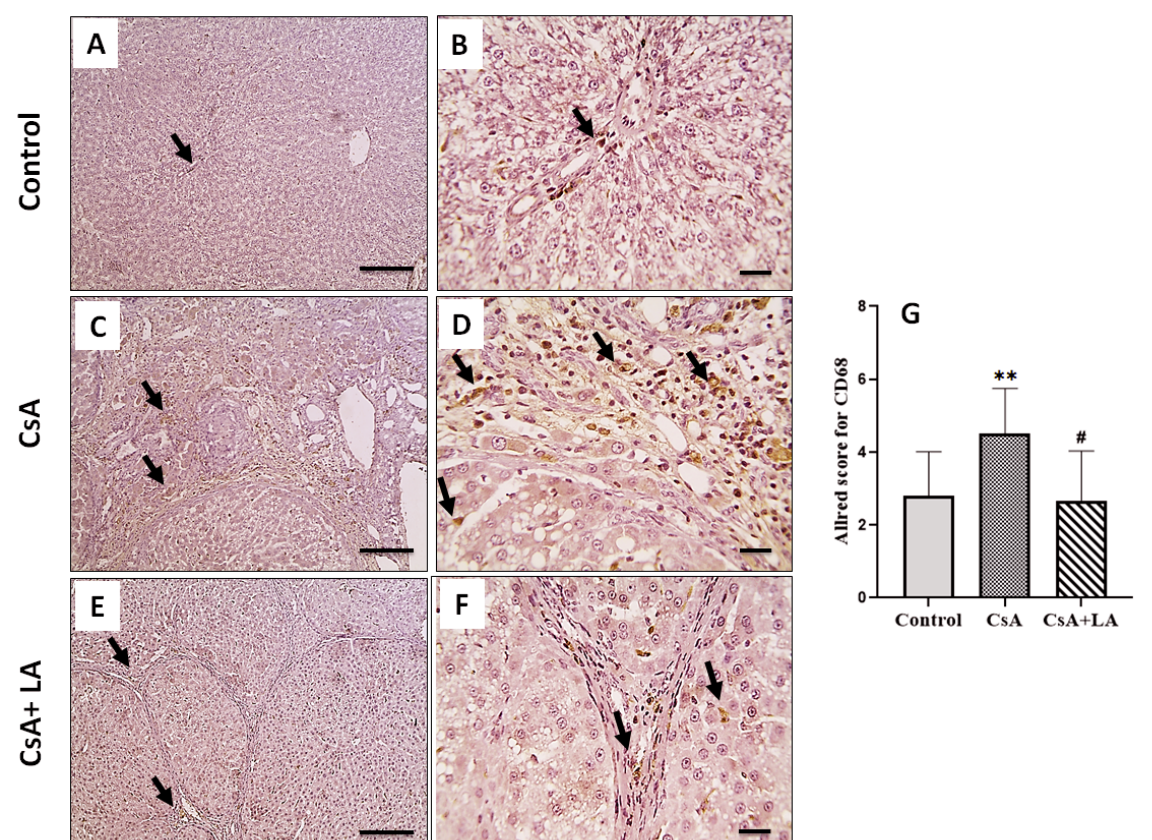
Figure 4. Microscopic pictures of immunostained hepatic sections against CD68. The control normal group ( A , B ) shows few positively stained cells in portal areas and sinusoids (arrows). Hepatic sections ( C , D ) from the CsA-treated group show markedly increased positively stained cells in portal areas and sinusoids (arrows). Hepatic sections ( E , F ) from (CsA + LA) treated group show significantly decreased numbers of positively stained cells in portal areas and sinusoids (arrows). IHC counterstained with Mayer’s hematoxylin, ( A , C , E ; Scale bar = 100 µ m), and ( B , D , F ; Scale bar = 50 µ m). ( G ) represents the Allred score for CD68 cellular expression. Data are expressed as mean ± SE ( n = 8). ** p < 0.01 versus the control group, # p < 0.05 versus the CsA group. Allred index (0–1 = negative, 2–3 = mild, 4–6 = moderate, and 7–8 = strongly positive).